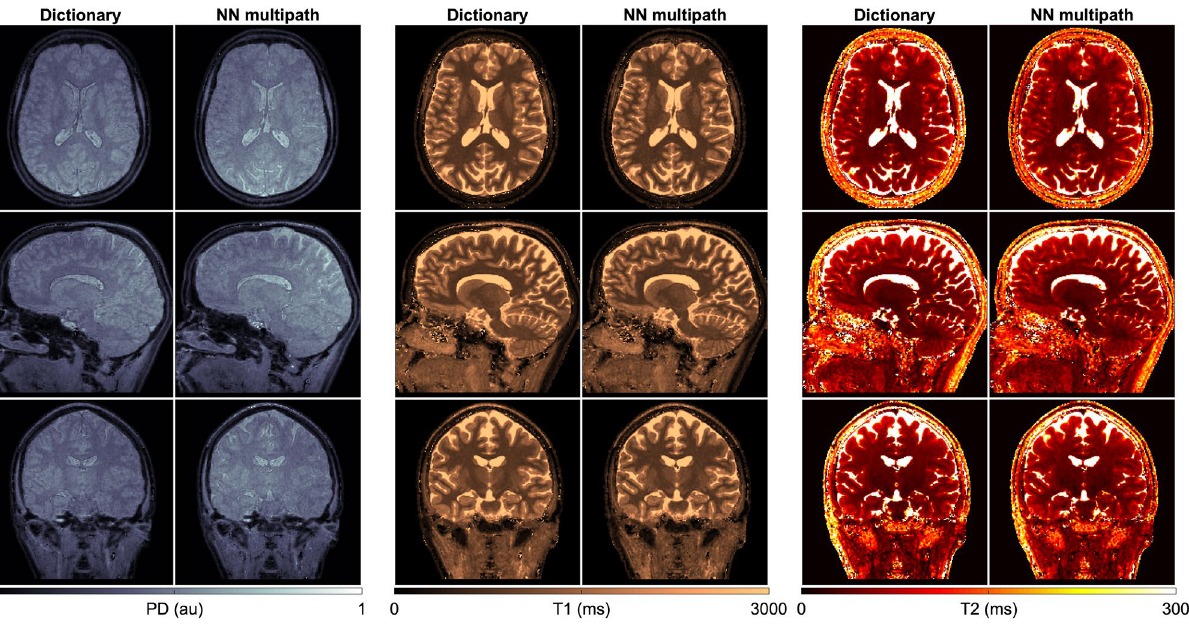
Figure 9. Parameter inference via multipath neural network inference and dictionary matching. Inferring parameter maps with a trained neural network and a high-resolution dictionary produces comparable results—with the key difference that the network is not limited by dictionary size or its discretization grid, and outperforms exhaustive grid search in terms of required memory and computation times.